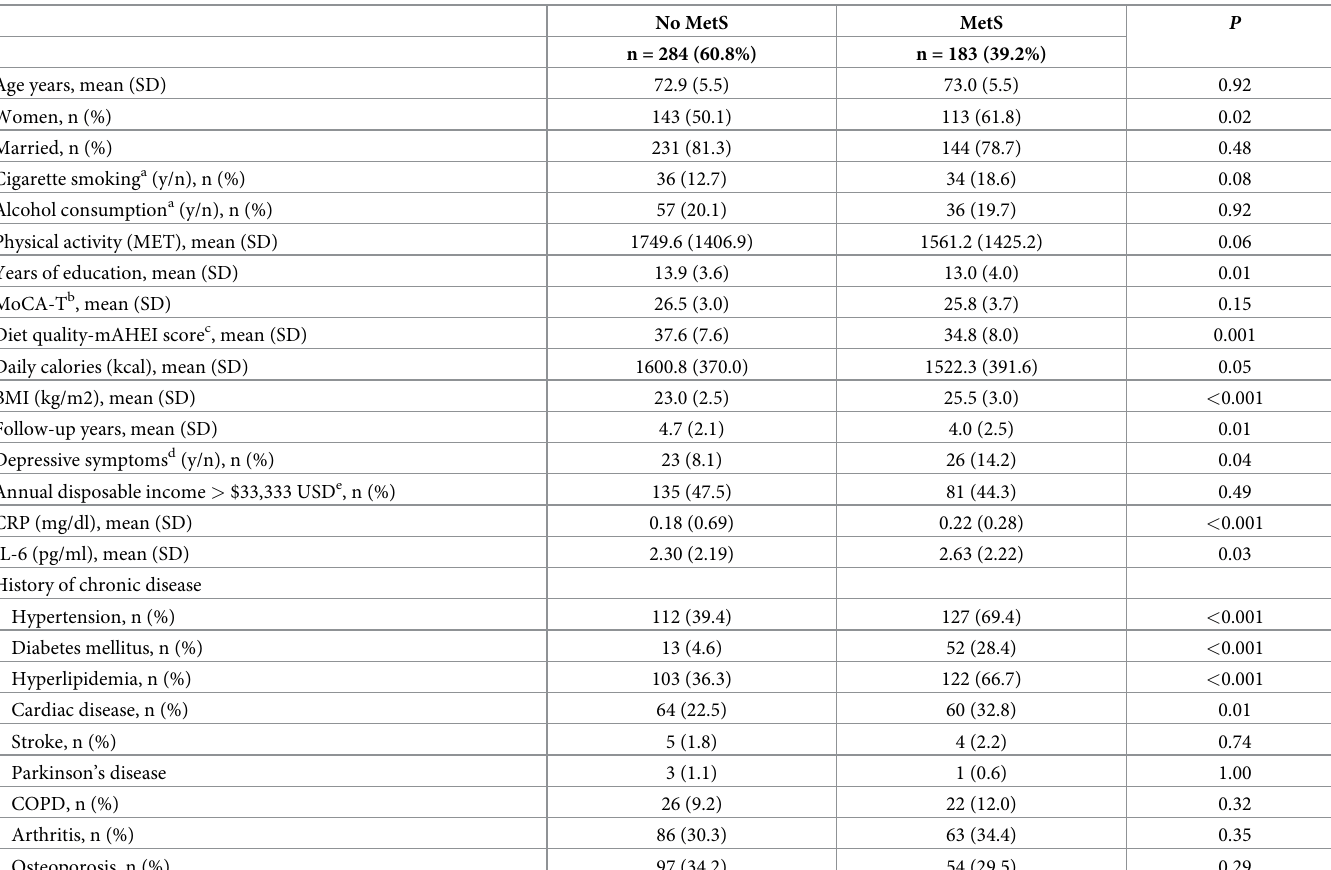
Table 1. Characteristics of the study population at baseline (2011–2013).